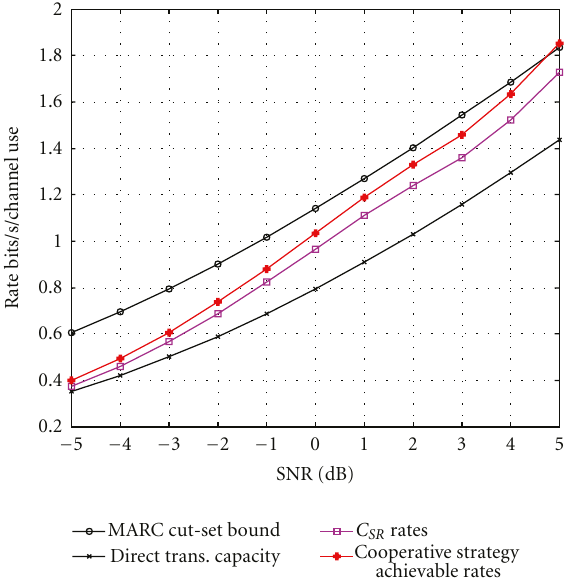
Figure 9: Achievable rates and capacity comparisons. Table 3: Parameters in simulation.